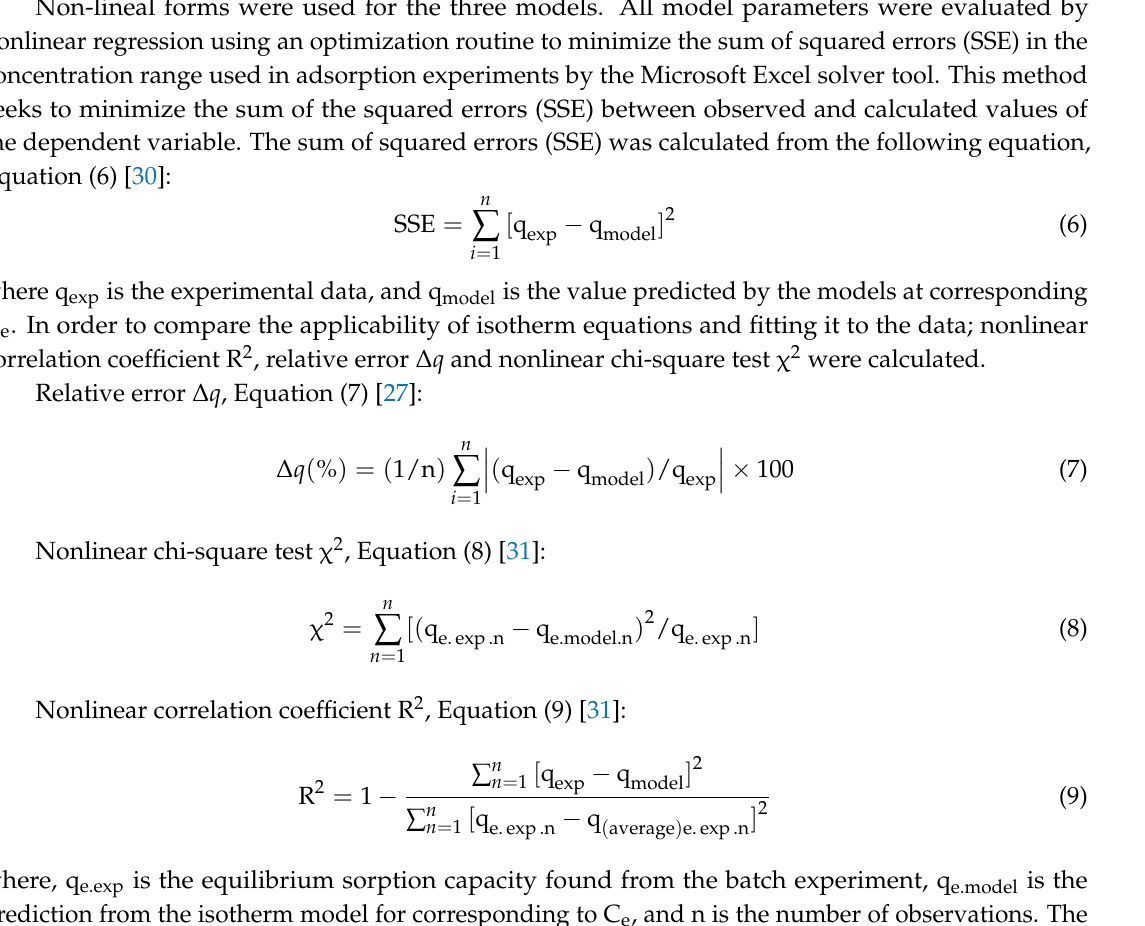
Figure 6. Plot of the effect of adsorbent dose on the adsorption of Cu 2+ ions at a concentration of 20 ppm of Cu 2+ at 24 h.